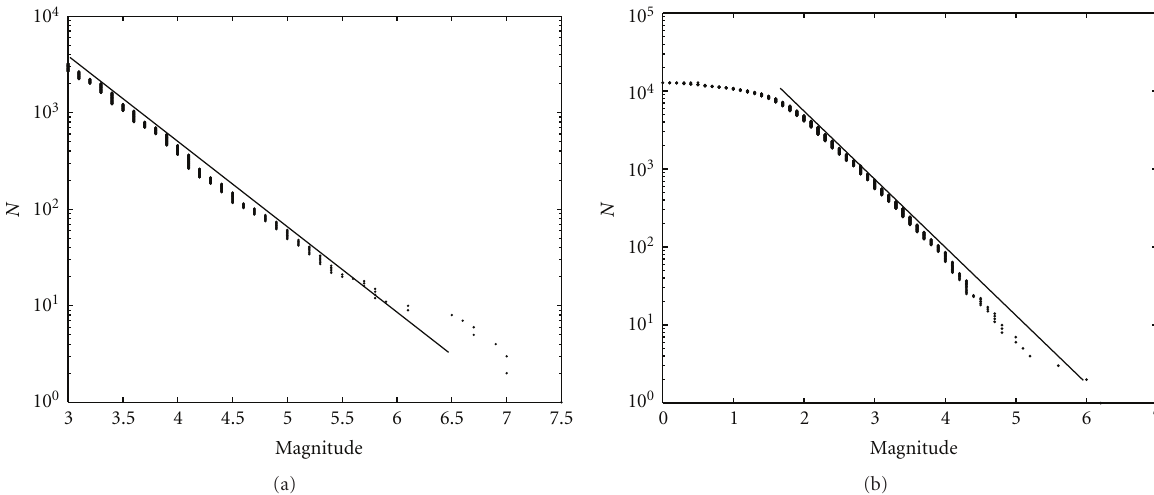
Figure 6: Gutenberg-Richter relations for both catalogs 1(a) and 2 (b); points—earthquakes of magnitude M in descending order, line shows the limits of validity of Gutenberg-Richter relation.